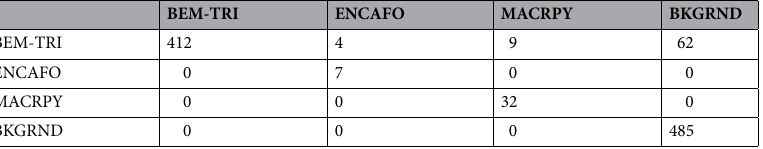
Table 8. Confusion matrix of classifications carried out with a time- and category-pooled training set (model 184) and tested on a category-pooled GH0d-7d image set.